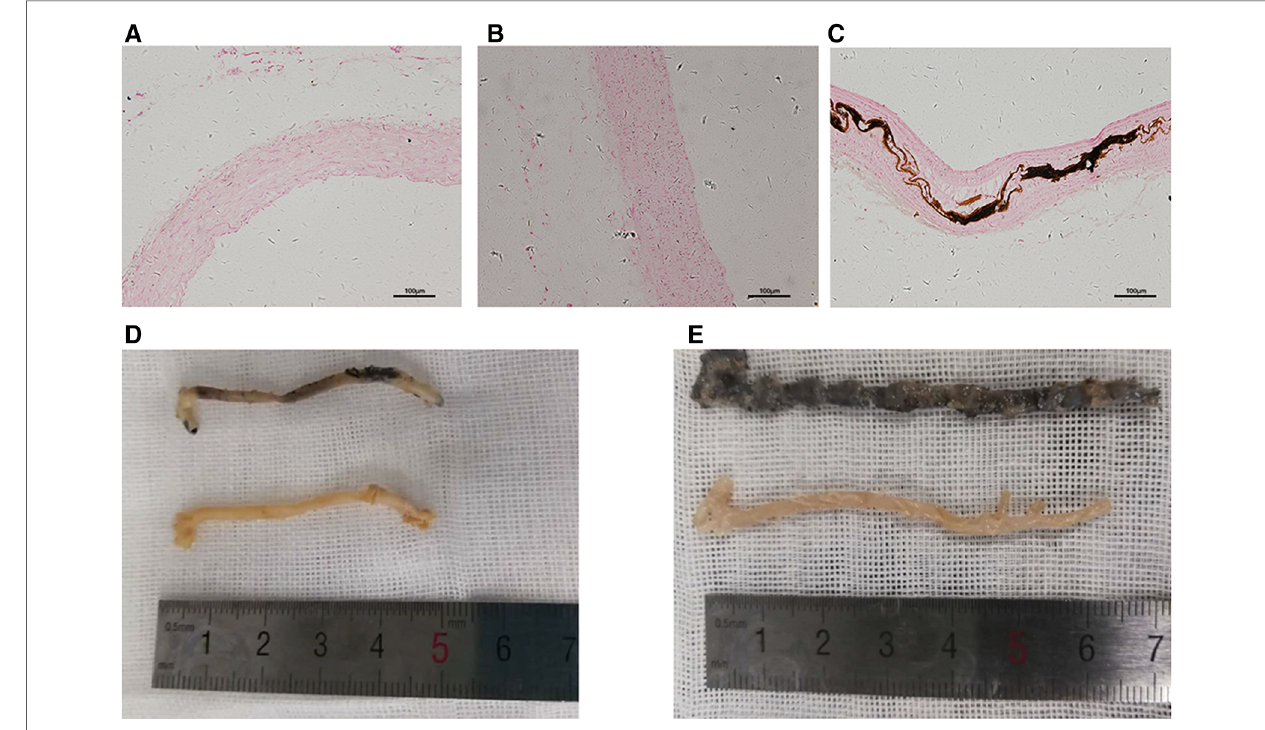
FIGURE 2 Calci fi cation of the aorta. ( A – C ) Representative sliced aorta Von Kossa staining imaging of the control group ( A ), non-VC group ( B ) and VC group ( C ). ( D,E ) Representative aorta Von Kossa staining imaging of the control group (below) and the non-VC group (D, upper), and VC group (E,